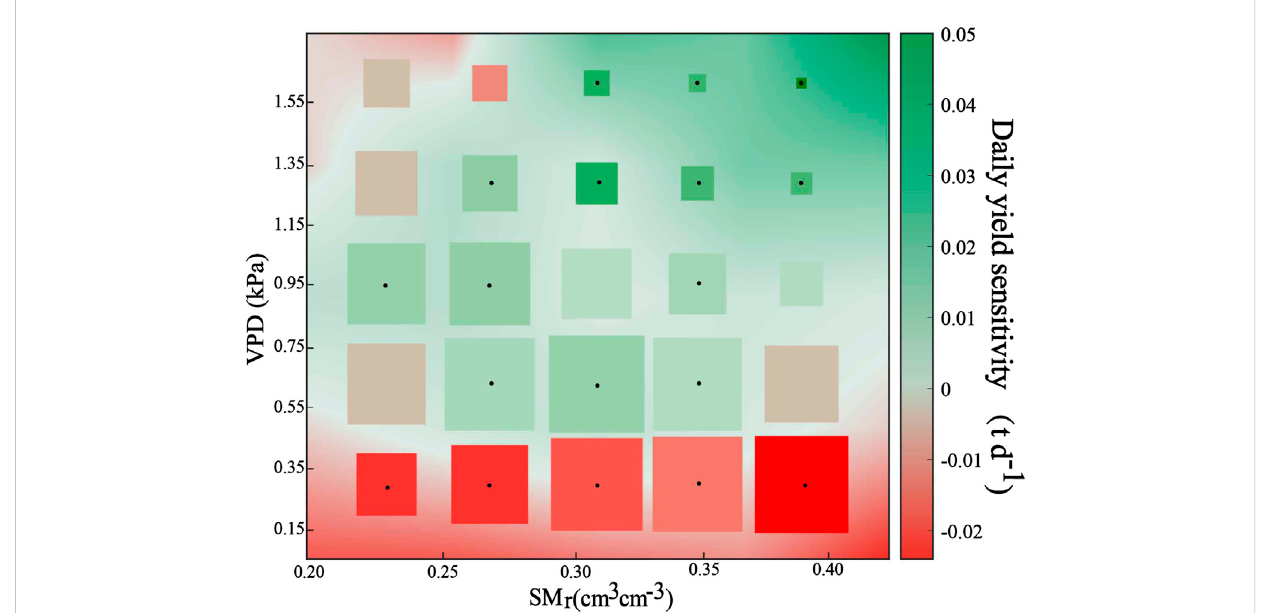
FIGURE 6 Theresponseofmaizeyieldstomoisturesupplyanddemandin2010 – 2016.Basedonobservationaldata,weestimatedthemaizeyieldresponsesto VPD androot-zonesoilmoisture.Thecolorofeachrectangleshows theestimateddaily maizeyieldsensitivity(i.e., β h factor)and theradiusofthesquare indicates the relative amounts of days falling in each value interval. The largest icon in the fi gure means 8.21% of the used data. The black dots in